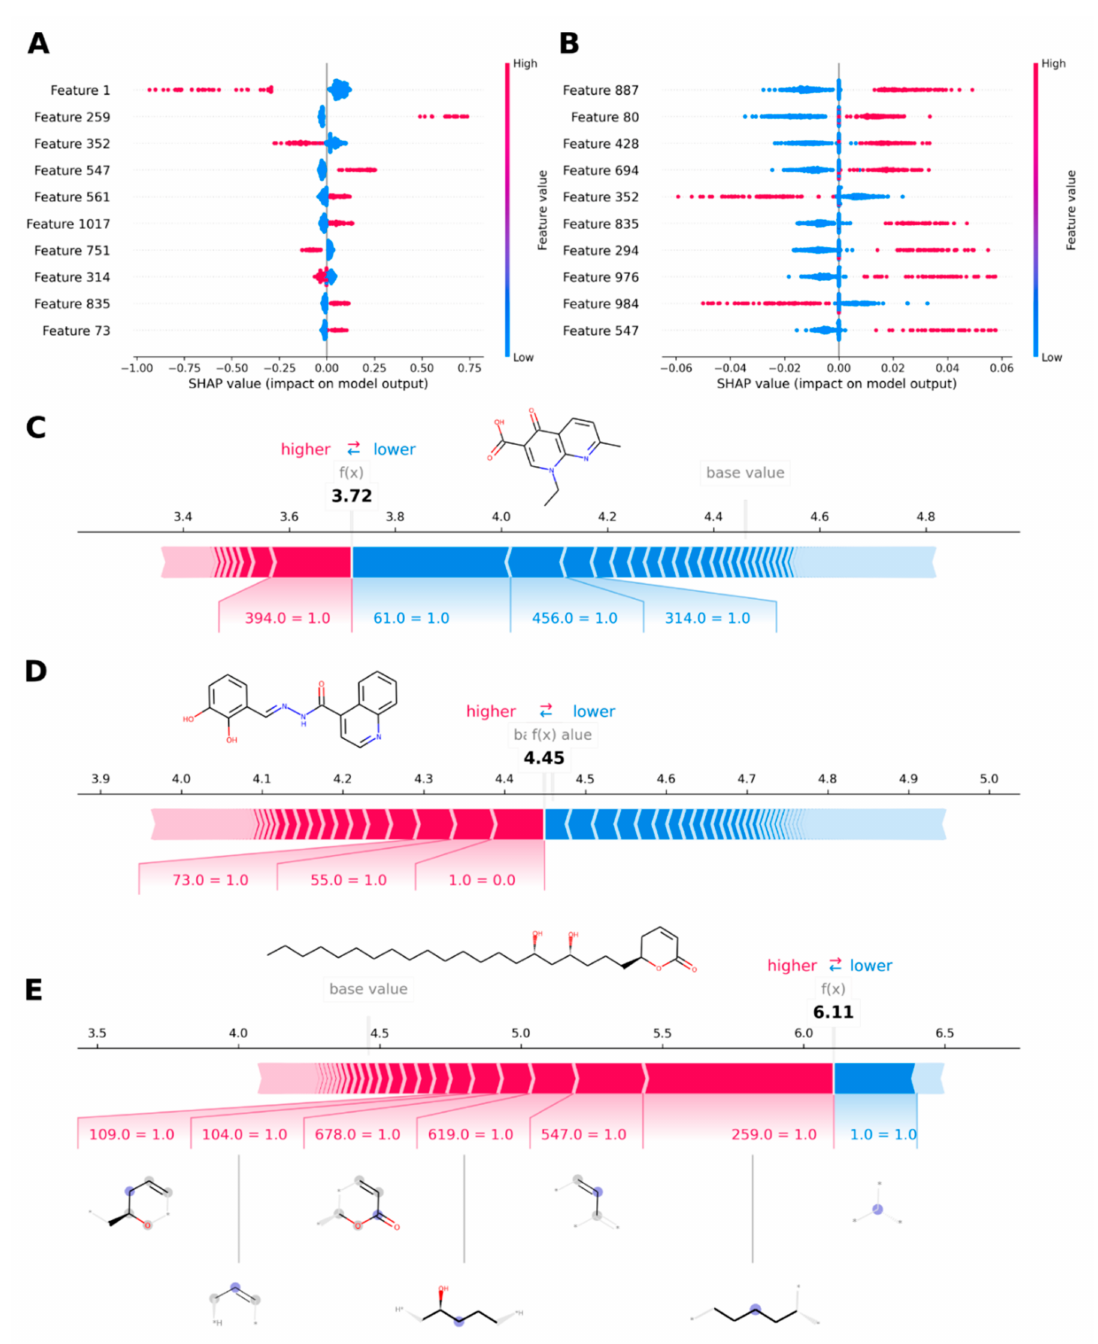
Figure 9. Contribution of structural features to M2 and M4. ( A ) SHAP values for M2 and ( B ) SHAP values for M4, colored by feature value (red: presence, blue: absence). ( C ) Force plot for a representative poorly active compound ( 190 ), ( D ) force plot for a representative compound with intermediate activity ( 586 ) and ( E ) force plot for a representative compound with high activity ( 164 ) as predicted by M2. Plot ( E ) includes the most important fingerprint bits a ff ecting the